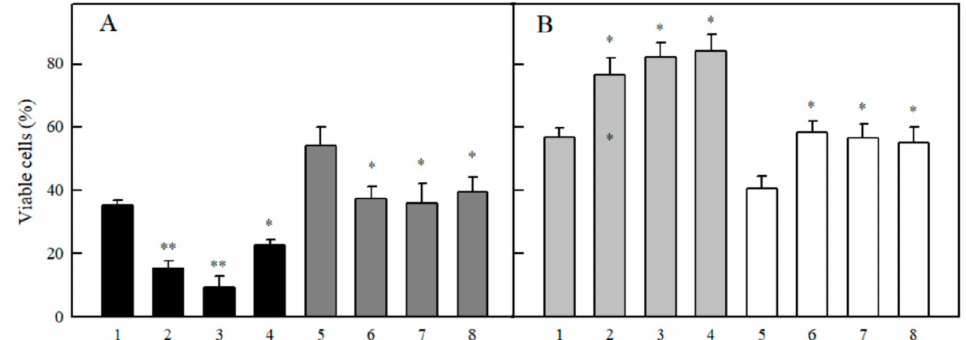
Figure 7. E ff ects of cytochrome P-450 inhibitors on the cytotoxicity of quinones and ArN → O in MH22a cells. ( A ) Cell viability in the presence of 5.0 µ M 9,10-phenanthrene quinone (1–4) and 50 µ M tetramethyl-1,4-benzoquinone (5–8), additions: none (1,5), + 5.0 µ M α -naphthoflavone (2,6), + 1.0 mM isoniazid (3,7), + 5.0 µ M miconazole (4,8). n = 3, p < 0.01 for 1 against 2,3 (**), p < 0.02 for 1 against 4, and for 5 against 6–8 (*). ( B ) Cell viability in the presence of 10 µ M 1,2,4-benzotriazine-1,4–dioxide (1-4) and 10 µ M 7-F-TPZ (5–8), additions: none (1,5), + 5.0 µ M α -naphthoflavone (2,6), + 1.0 mM isoniazid (3,7), + 5.0 µ M miconazole (4,8). n = 3, p < 0.02 for 1 against 2–4, and for 5 against 6–8 (*). Additions of P-450 inhibitors did not a ff ect the cell viability in control experiments,